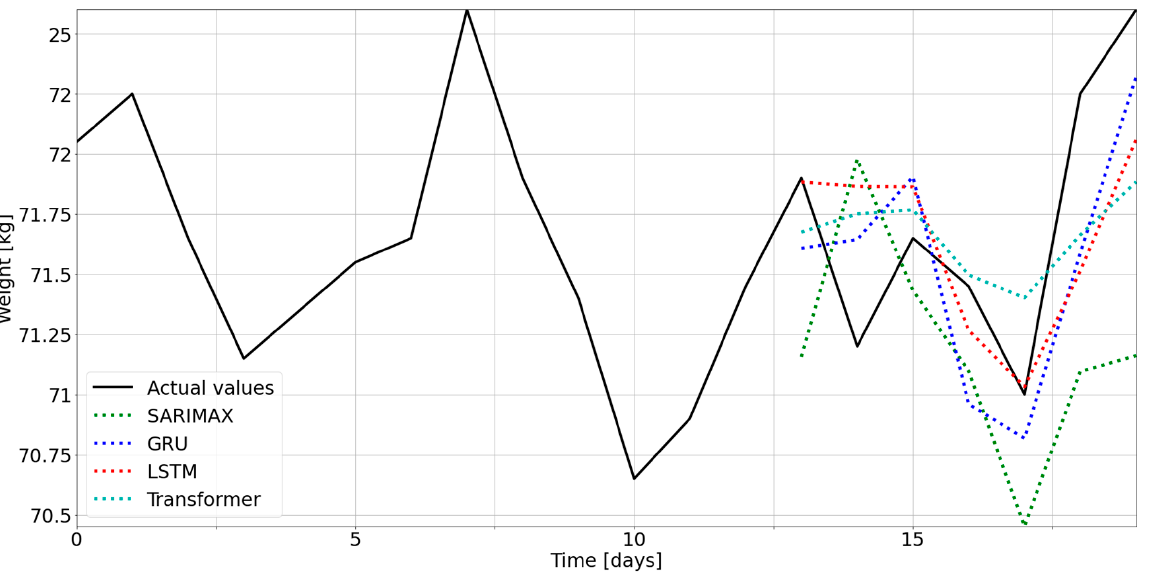
Figure 5. Predictions of test set of user 0, for all models.